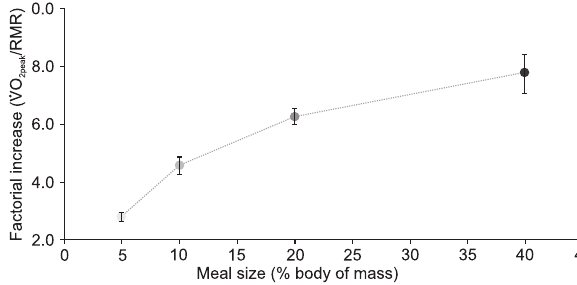
Figure 2. Factorial increment of the postprandial metabolism in relation to the rates measured during fasting (RMR) for Bothrops alternatus (mean values ± SE, n = 6) fed with rodent prey of differ- ent relative